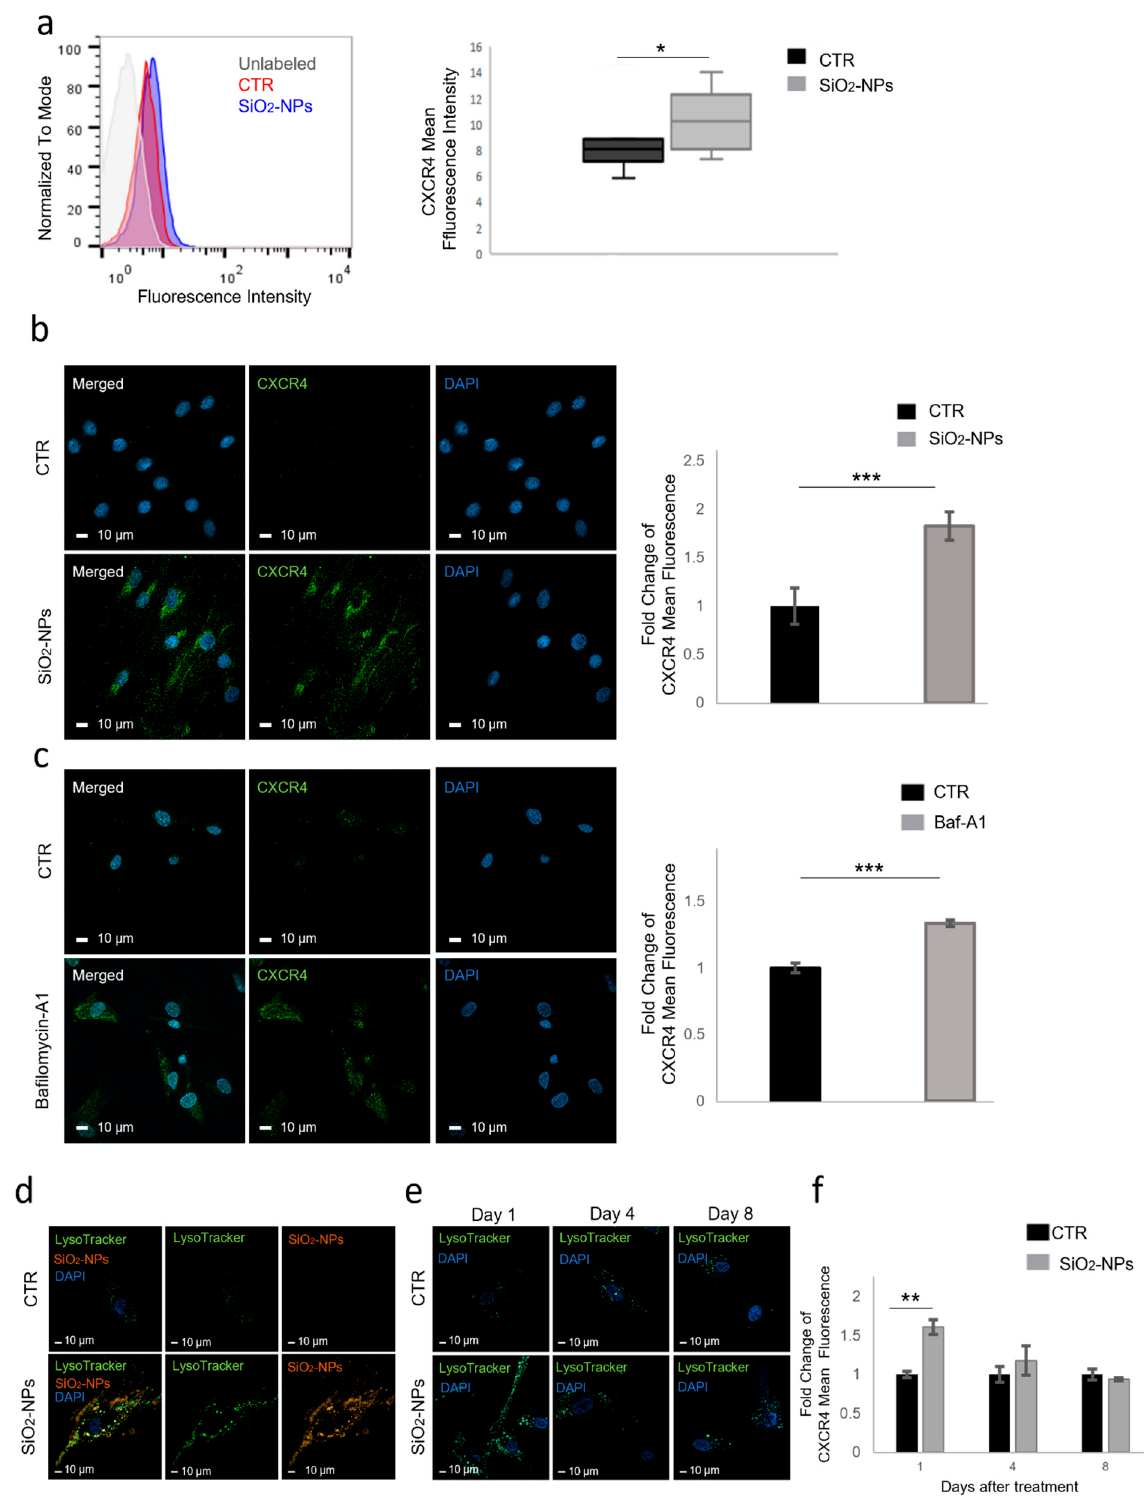
Figure 1. SiO 2 -NP internalization increases CXCR4 expression in hMSCs. ( a ) Fifty thousand of both living untreated (CTR) and SiO 2 -NP-treated hMSCs were incubated with anti-CXCR4 antibody and fluorescence intensity was measured by flow cytometry after 16 h of SiO 2 -NP treatment. Data shown are cytometric profiles of a representative sample from each experimental group: background signal of cells without antibody incubation (grey), control cells (red), SiO 2 -NP-treated cells (blue).